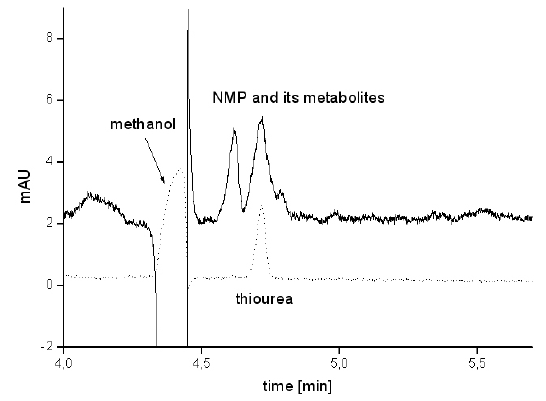
Figure 2. Peaks resulting from the injection of NMP and its metabolites along with thiourea (10 mg L -1 each in water) and diluted methanol as EOF marker in a sodium cholate micellar system (150 mM SC, 10 mM phosphate, pH 7.1, electric field strength 400 V cm -1 , electric current 69 µA, direct UV detection at 200 nm (solid line) and 238 nm (dotted line)).